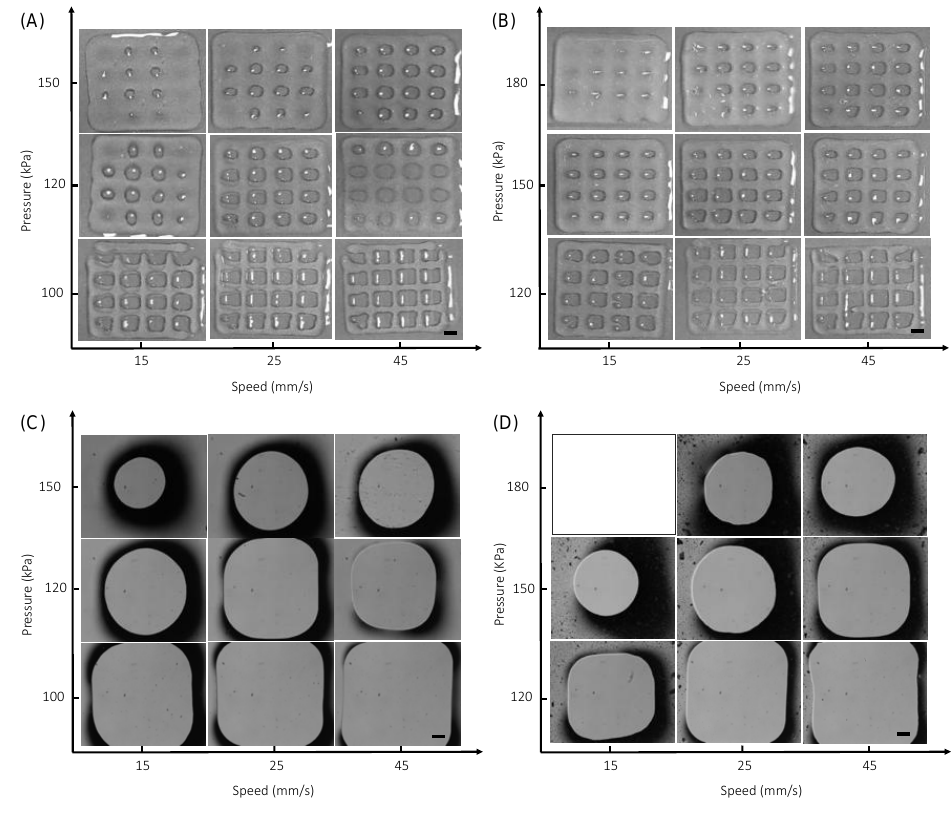
Figure 7. Printability studies via printing grid patterns using ( A , C ) neat ( N ) and ( B , D ) composite ( C ) inks. ( A , B ) Pictures showing 3D printed grid patterns with respect to print pressure and speed. Scale bars are 1 mm. ( C , D ) Bright field images showing a representative pore for each scaffold. Scale bars are 200 microns.